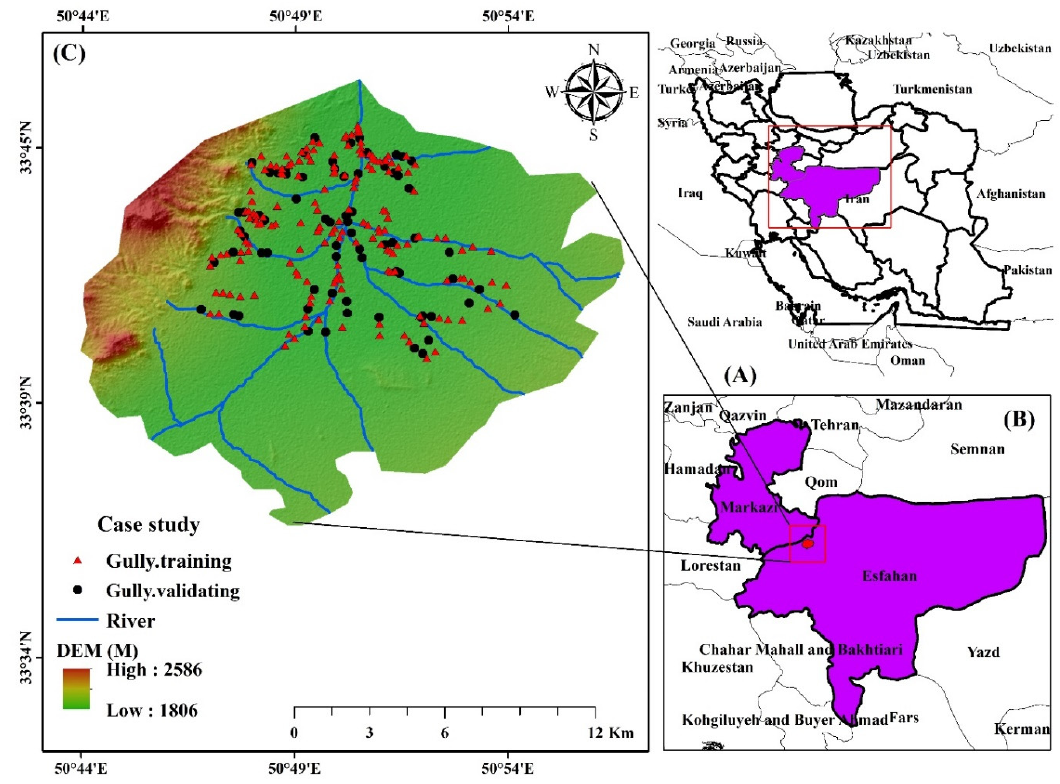
Figure 1. ( A ) the Markazi and Isfahan Provinces in Iran, ( B ) the study area in the Markazi and Isfahan Provinces, and ( C ) gully erosion situations with a DEM map of the Robat Turk Watershed.